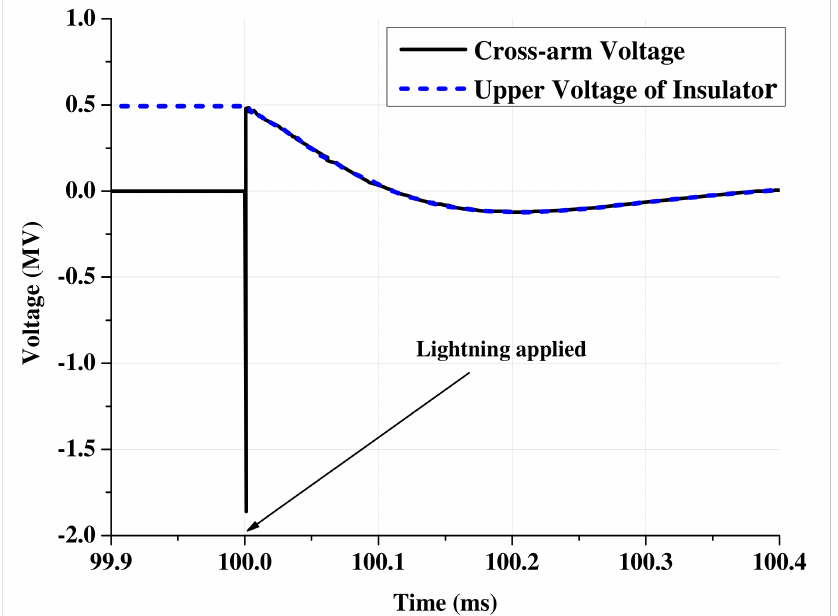
Figure 13. Voltage at tower cross-arm point and upper point of insulator with 50 kA lightning current.